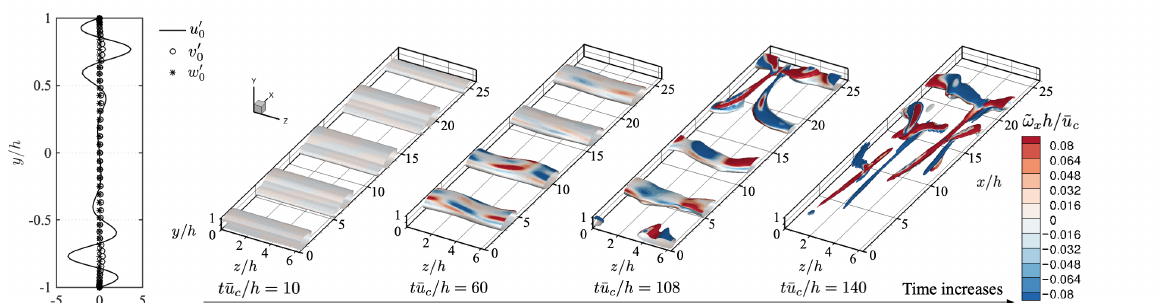
Figure 6. Time evolution of flow field to illustrate the laminar-to-turbulent transition process for the case ( α , β ) = ( 1,0 ) : The flow is initialized by optimal disturbance with kinetic energy density ( h / ¯ u c ) 2 = 0.005) colored by streamwise vorticity of E 0 = 1.0 10 − 4 . Iso-surfaces of -criterion ( × Q Q ˜ ω x h / ¯ u c are visualized. Only the upper half domain ( y 0) is displayed for ≥